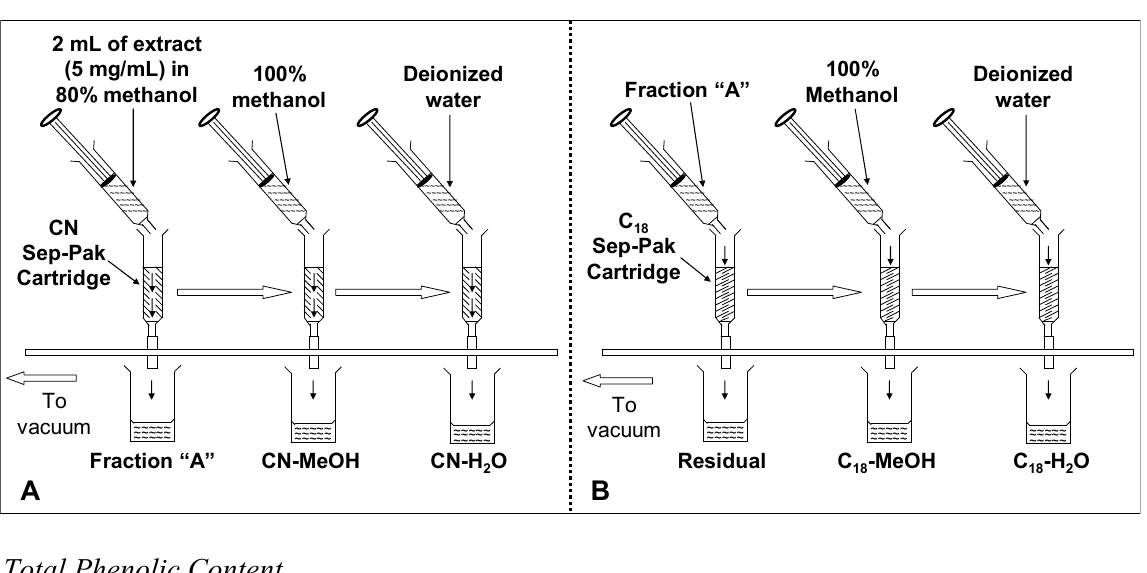
Figure 7. Procedure for fractionation of defatted dabai extracts applying solid phase extraction. Crude extracts of defatted dabai peel and pulp-peel were fractionated based on procedure ( A ), followed by procedure ( B